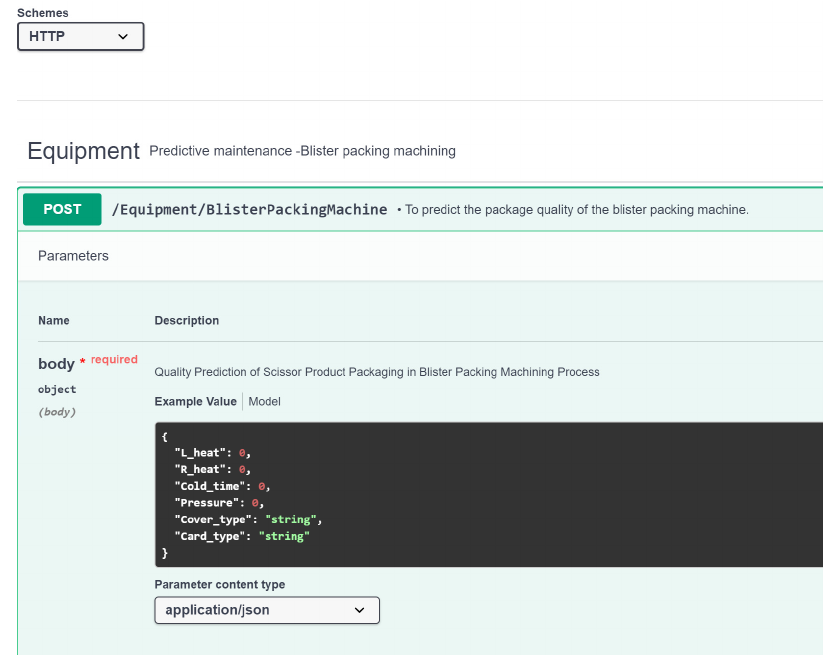
Figure 9. The interface of the RESTful